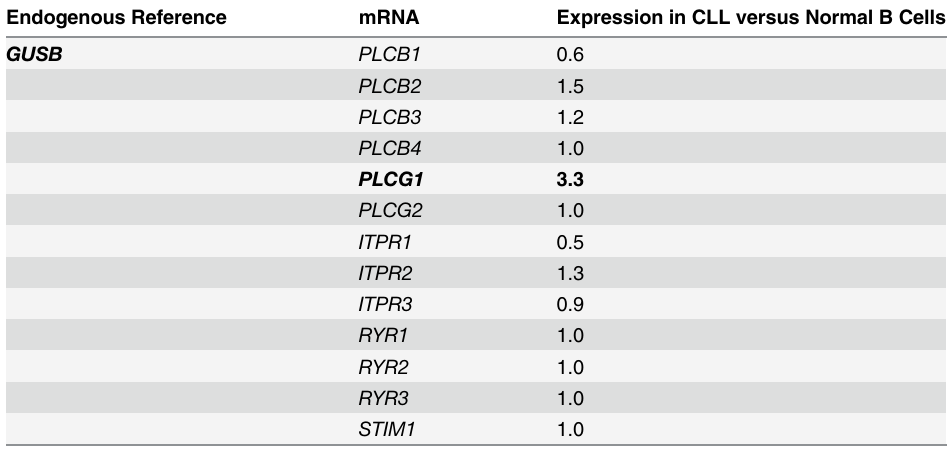
Table 4. Transcript expression levels of Ca 2+ -related signaling